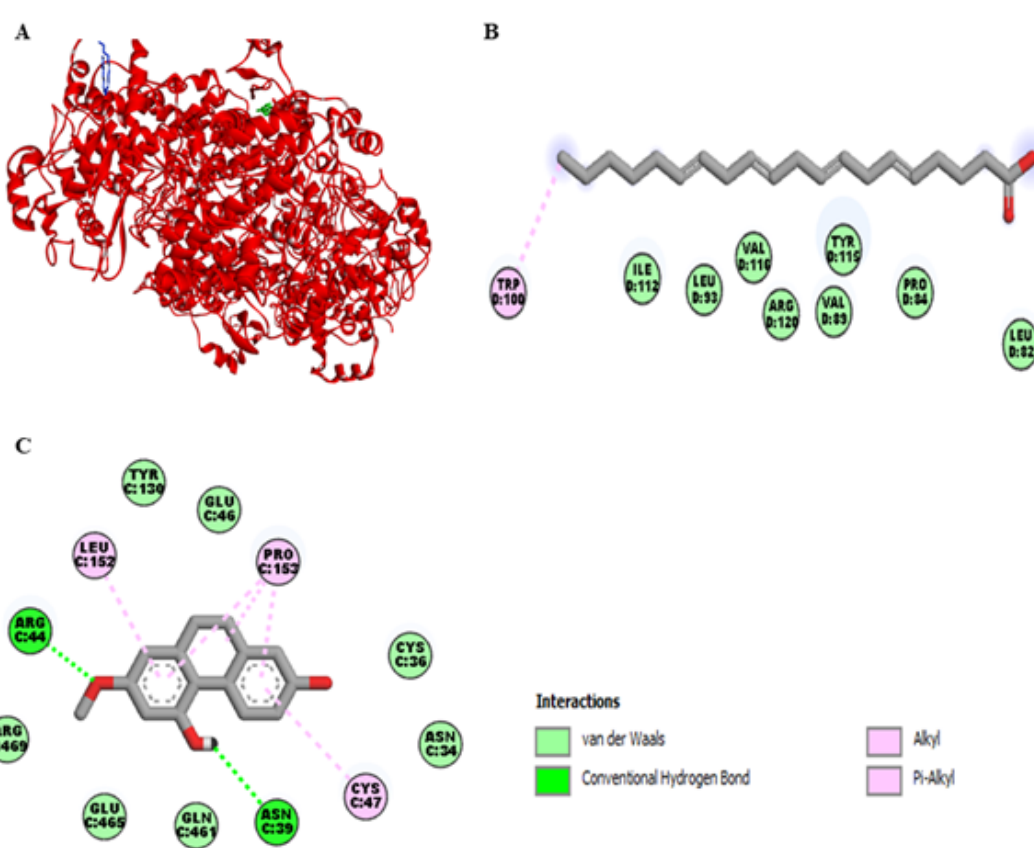
Figure 5. The inhibitory effects of various concentrations of lusianthridin on the activities of ( A ) COX-1 and ( B ) COX-2 enzymes. Tested compounds were incubated directly with COX-1 or COX-2 in the assay buffer for 5 min and then the activities were measured by a COX fluorescent inhibitor screening assay kit. SC-560, a COX-1 selective inhibitor, and DuP- 697, a COX-2 selective inhibitor, were used as positive controls. Data are presented as means ± SEMs ( n = 3). * p < 0.05, ** p < 0.001, *** p < 0.0001 compared with control.